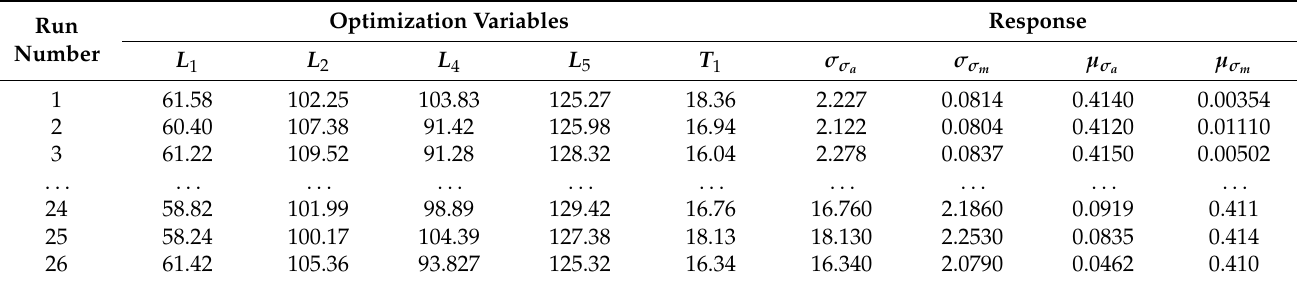
Table 7. DoE design and response values of the second-layer Kriging surrogate model.